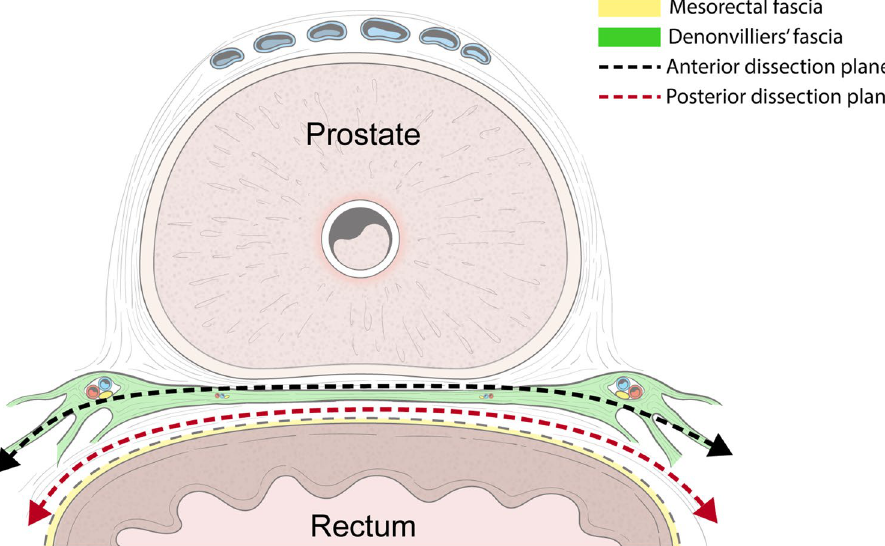
Figure 5. Schematic representation of the relationships of the correct surgical plane during an anterior total mesorectal excision to the Denonvilliers’s fascia in the male. The authors would like to thank Dong-Su